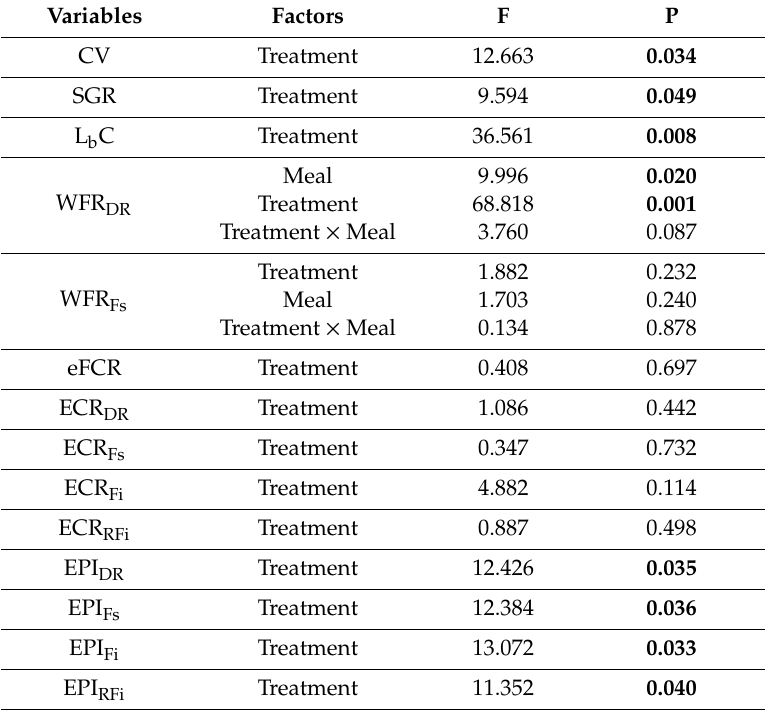
Table 6. Results of the repeated measures analysis of variance (RM-ANOVA) comparing growth performance, waste production and economic profitability variables among experimental feeding treatments ( p -values in bold indicate significant di ff